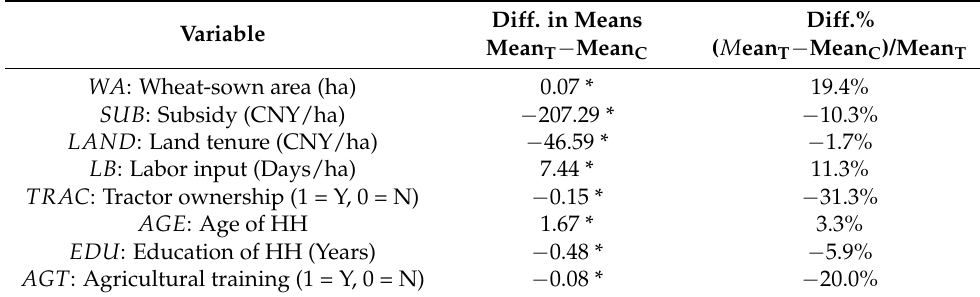
Table 2. Differences of variables between the treatment and control groups. Variable